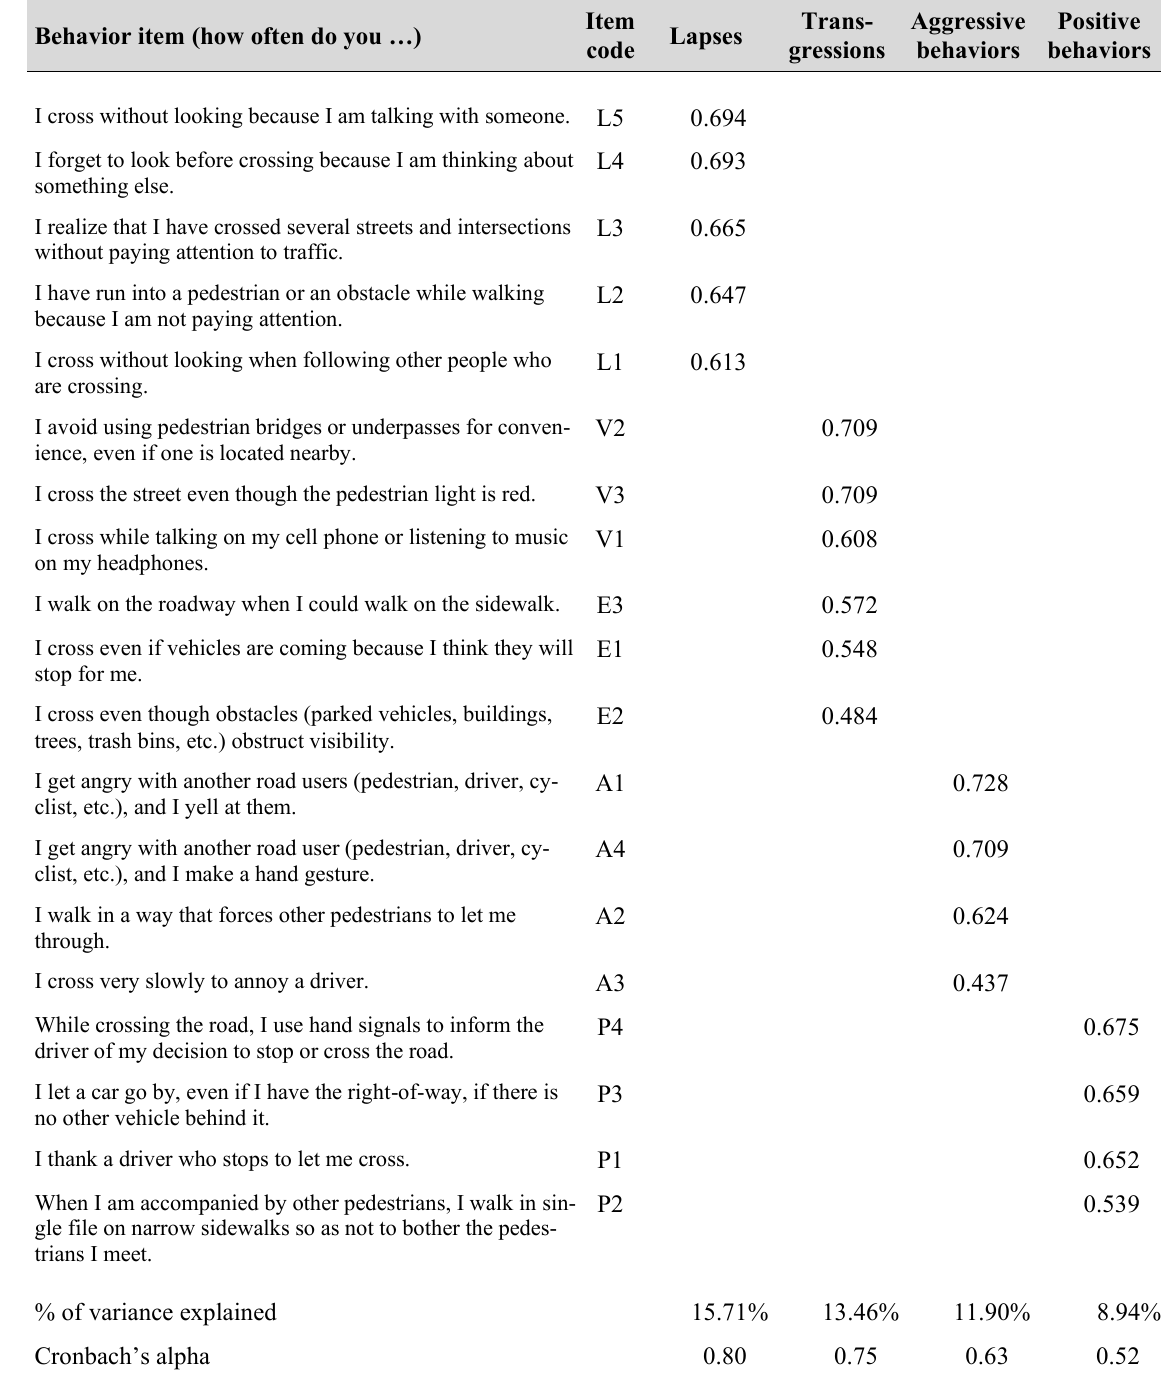
Table 3 Principle component analysis